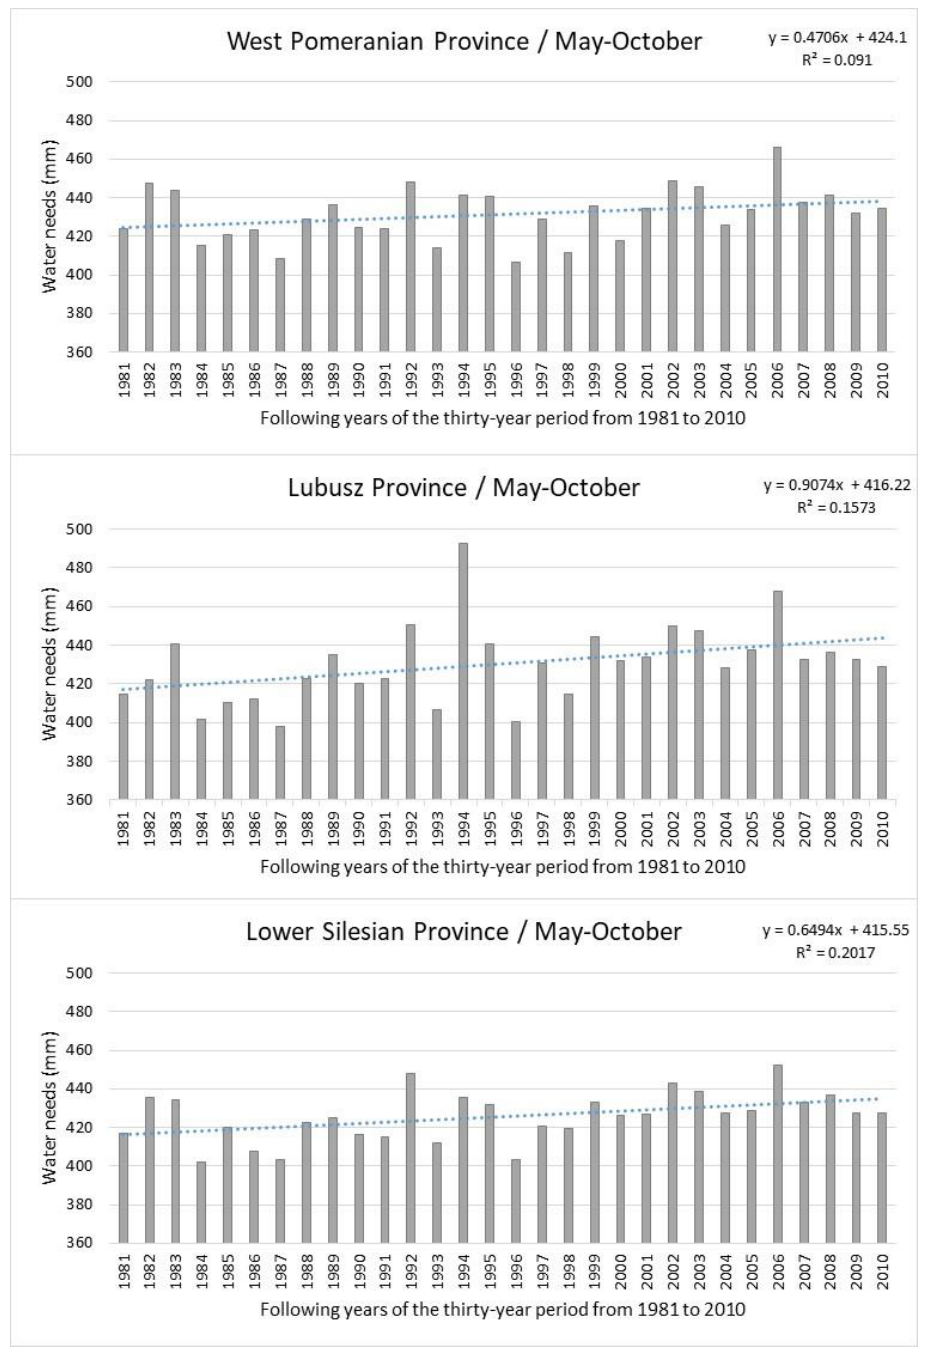
Figure 3. Time trend of water needs of grapevines during the growing season (May–October) in 1981–2010 in the western provinces of Poland.